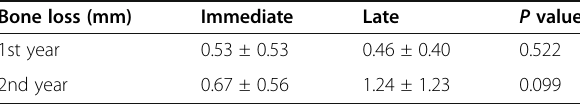
Table 5 Marginal bone loss of implants in different loading protocols Bone loss